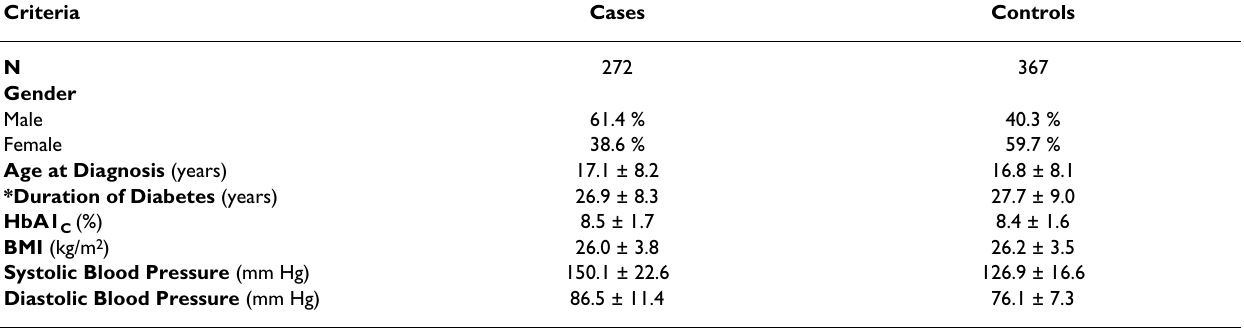
Table 1: Clinical characteristics of cases (n = 272) and controls (n = 367) (Data are n, mean ± SD)